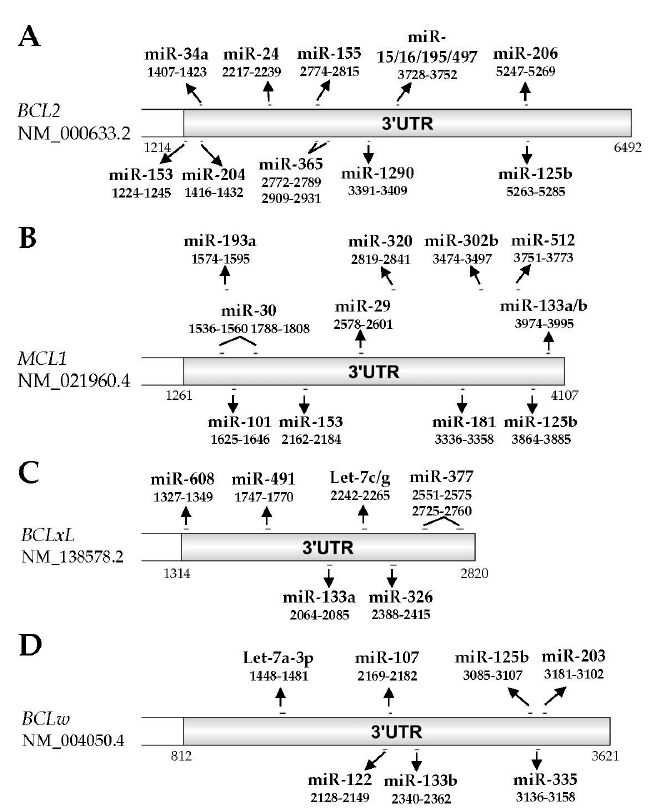
Figure 3. Validated miRNA binding sites on the 3 ′ untranslated region (UTR) of anti-apoptotic family members. A schematic diagram of 3 ′ UTR of BCL2 (NM_000633.2, nucleotides 1214–6492), MCL1 (NM_021960.4, nucleotides 1261–4107), BCLxL (NM_138578.2, nucleotides 1314–2820), and BCLW (NM_004050.4, nucleotides 812–3621). Validated miRNAs and their binding positions to each mRNA transcript are shown in line.